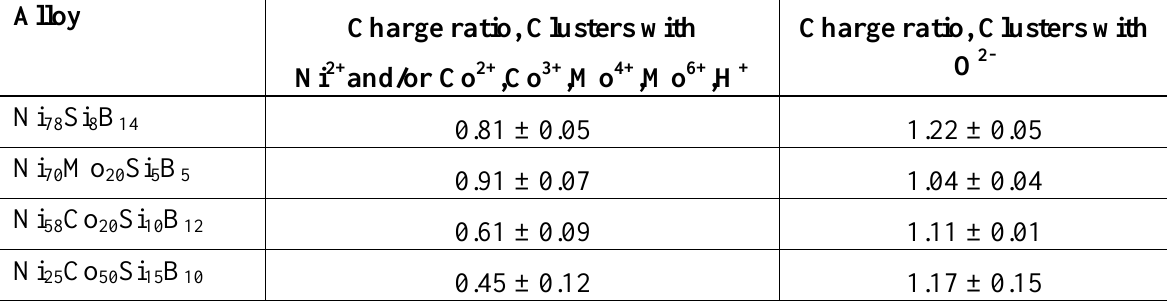
calculated from the STS curves in Figures